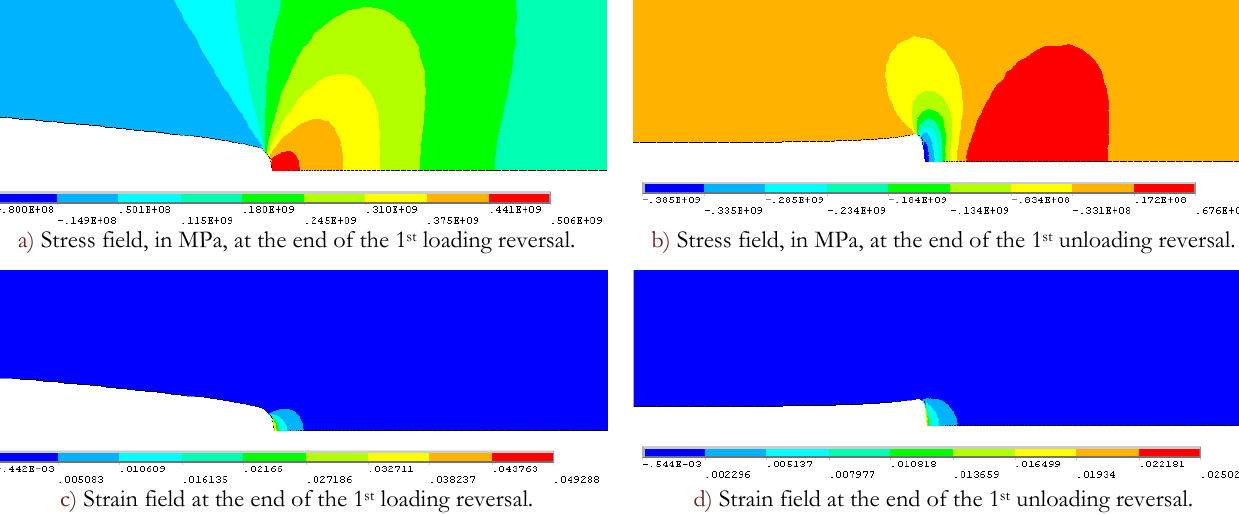
Figure 14: Stress and strain fields, along the load direction, obtained for the CT specimens made of S355 steel, resulting from elastoplastic finite element analysis ( ρ * =55µm, a =15mm, R